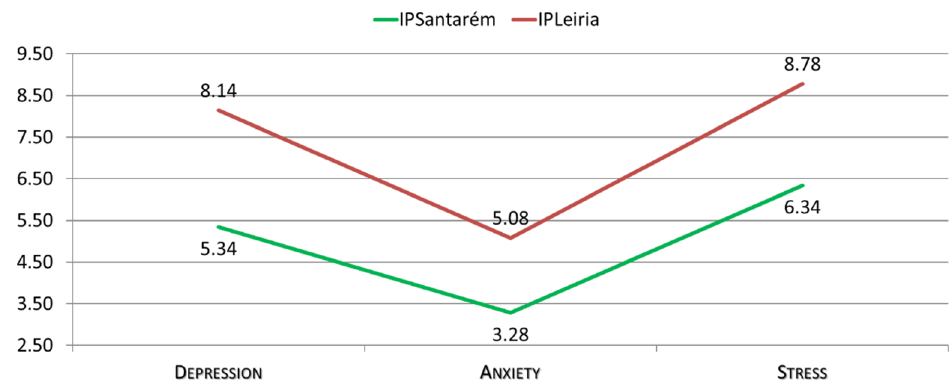
Figure 1. Institute attended by the DASS-21 subscales.